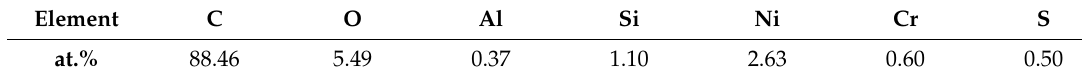
Figure 7. STEM image of the spent Ni–Cr catalyst after the second upgrading at 325 ◦ C. Table 5. STEM-EDX spent Ni–Cr catalyst after the second upgrading at 325 ◦ C.